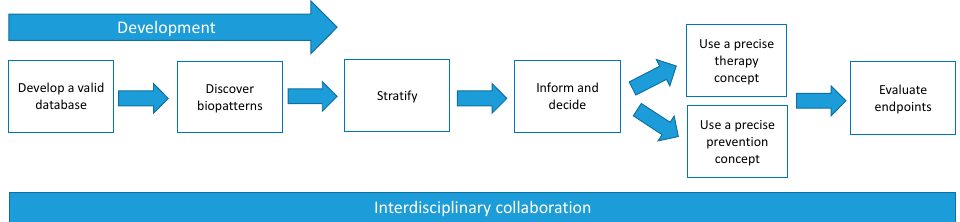
Figure 1. Professionals’ work in PM.